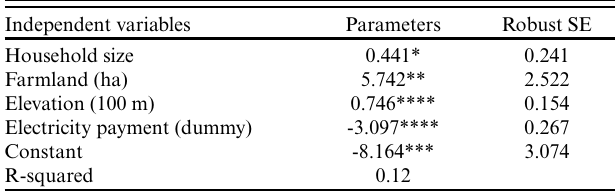
Table 1 . Pooled Ordinary Least Squares of fuelwood use pattern